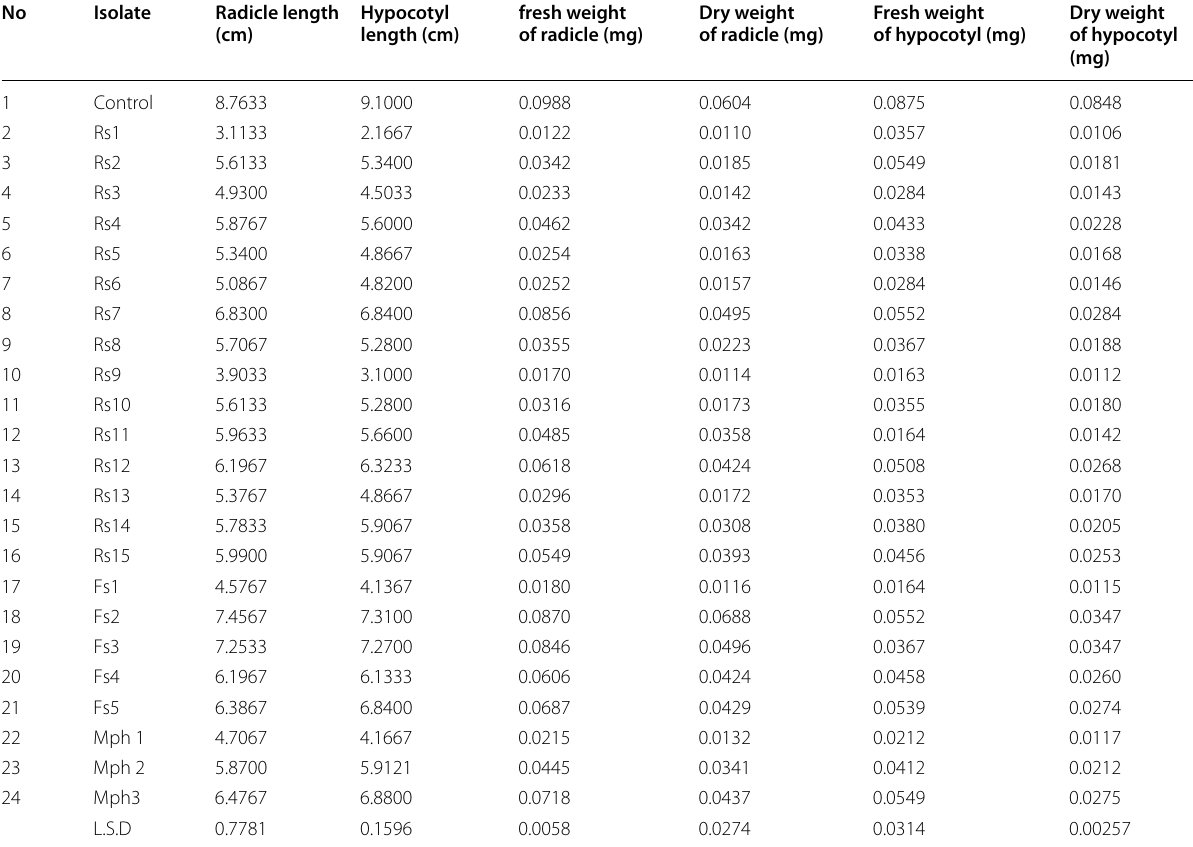
Table 6 The length of the radicle and the hypocotyl (cm) and the fresh and dry weight (mg) of the radicle and the hypocotyl of wheat in the